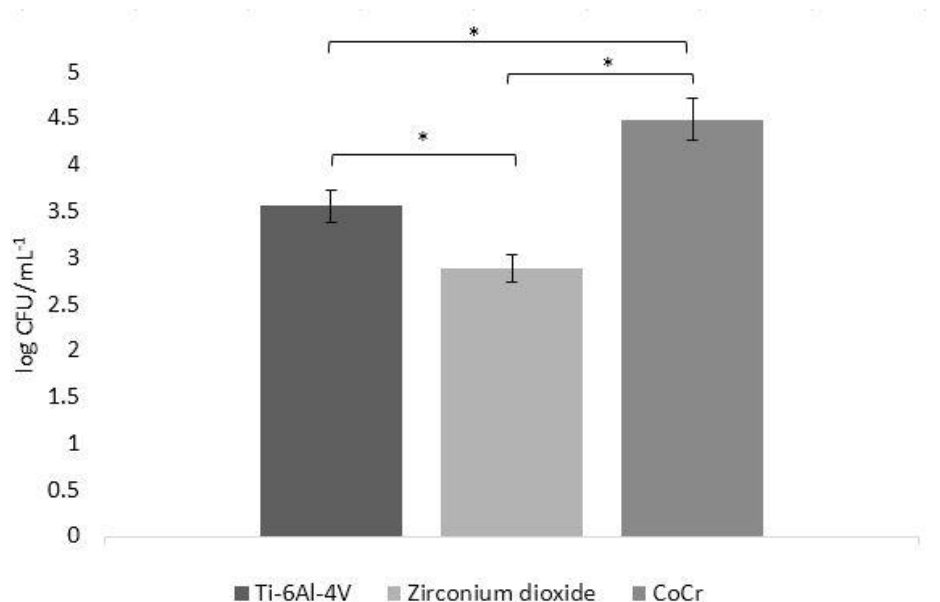
Figure 2. Biofilm formation (in colony-forming units (log CFU/mL-1)) on the surfaces of different biomaterials. Error bars represent the pooled standard deviations of the mean ( n = 5). The level of significance was preset at * p = 0.05. The mean and standard deviation are shown.